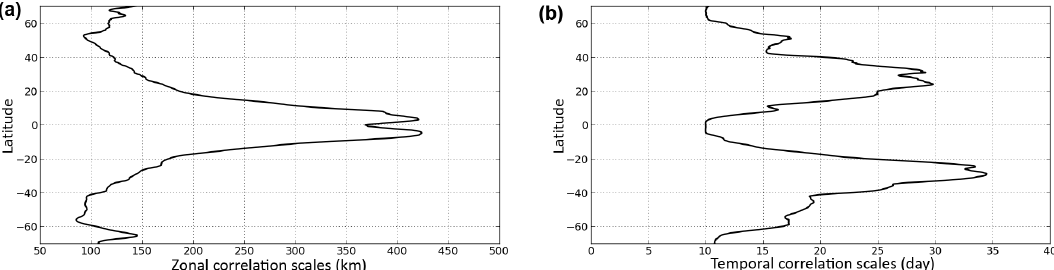
Figure 4. Evolution of the mean zonal (left) and temporal (right) correlation scales according to the